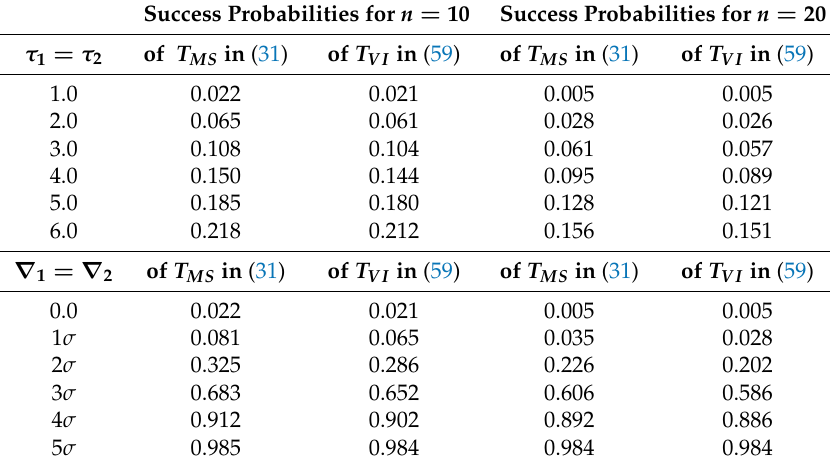
Table 4. Success probabilities for outlier identification in repeated observations of equal variance σ 2 with two outliers.